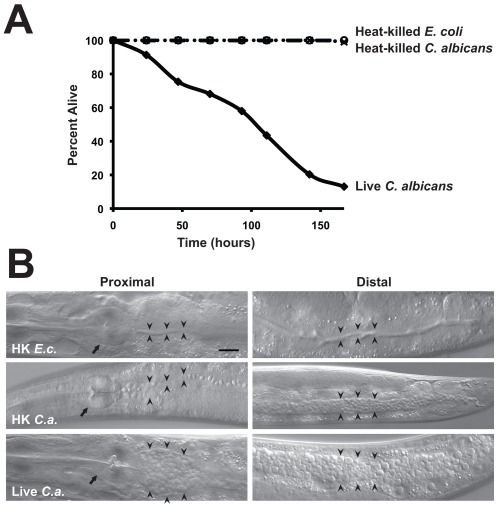

C. albicans yeast can kill C. elegans.(A) Live C. albicans (closed diamonds) were pathogenic to nematodes on solid media, whereas heat-killed C. albicans (open circles) and E. coli (crosses) were not (P<0.001). The graph presents the average of three plates per strain, each with 30 to 40 animals per plate. Data are representative of two biological replicates. (B) Images of C. elegans animals exposed to heat-killed E. coli (HK E.c.), heat-killed C. albicans (HK C.a.) or live C. albicans (live C.a.) for 16 hours at 25°C are shown. Images of the proximal (left) and distal (right) intestine were obtained using Nomarski optics. Both live and heat-killed C. albicans accumulated within the intestine, but only live C. albicans caused marked distention of the proximal intestine. Arrows point to the pharyngeal grinder and arrowheads outline the lumen of the intestine. The scale bar represents 20 µm.